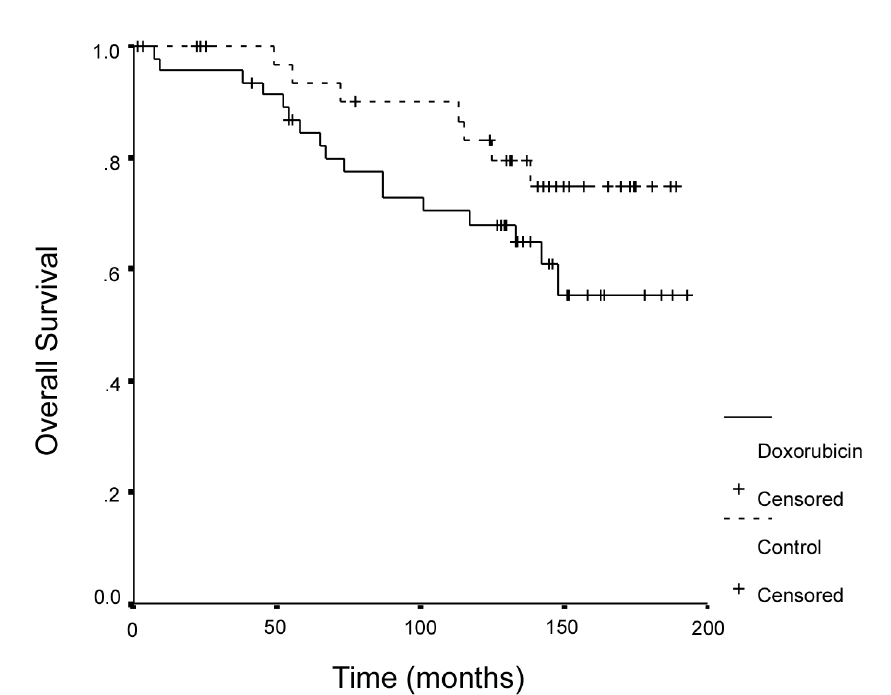
Figure 4 – Overall survival curves of doxorubicin group (solid line) and control group (dotted line). Log rank test, p =